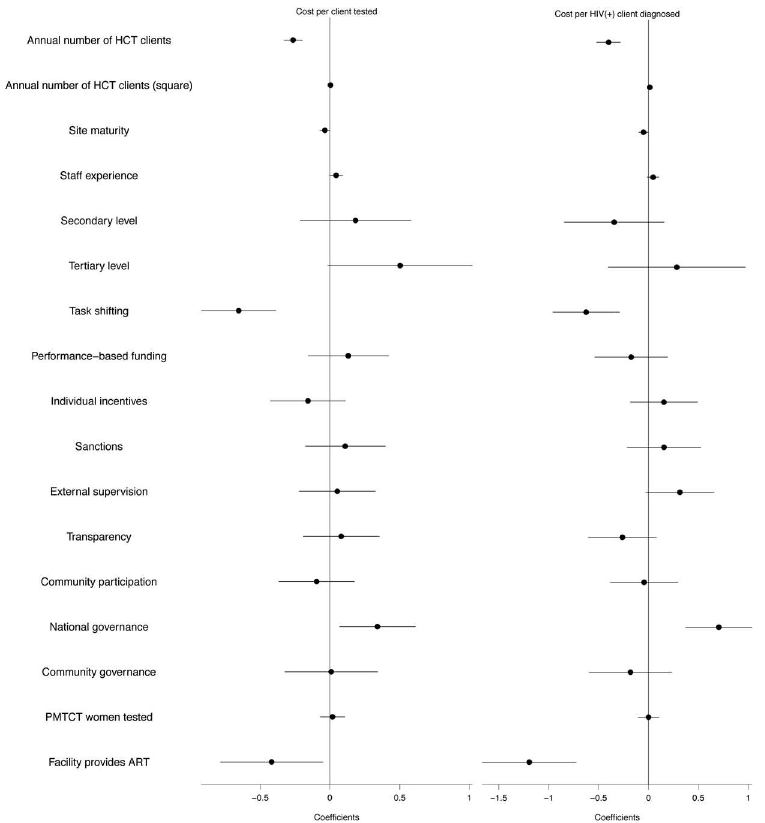
Fig 7. HCT regression models along the service